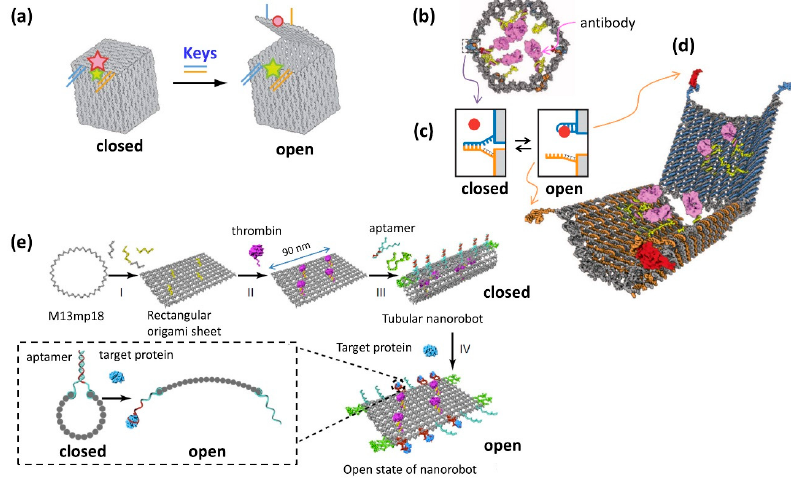
Figure 7. DNA nanorobots with open/close switch for biological applications. ( a ) Controlled opening of the box lid using toehold containing DNA strands (keys) [37]. ( b ) DNA nanorobot that recognizes cells and activating signaling pathway in the cell [39]. Nanorobot in a closed state. Antibodies are attached inside the barrel-shaped structure and are closed by DNA strands that used as “locks” (dashed rectangle). ( c ) Mechanism of opening the structure by use of “key”. The target molecule (red circle) binds to the blue DNA strand (aptamer DNA), and the initial dsDNA dissociates. ( d ) Nanorobot in an opened state. Internal antibodies bind to cell-specific antigens. The nanorobot opens with two kinds of target molecules, so that only when two molecules exist, it binds to the cell surface. Cells can be Identified in a logic gated way. ( e ) DNA nanorobot targeting specific tumor [29]. Thrombin is attached to the sheet, and the structure is closed in a tubular shape by aptamers. When a tumor associated target protein is attached to the aptamers, the tubular nanorobot opens to expose the thrombin, which performs blood coagulation at the tumor